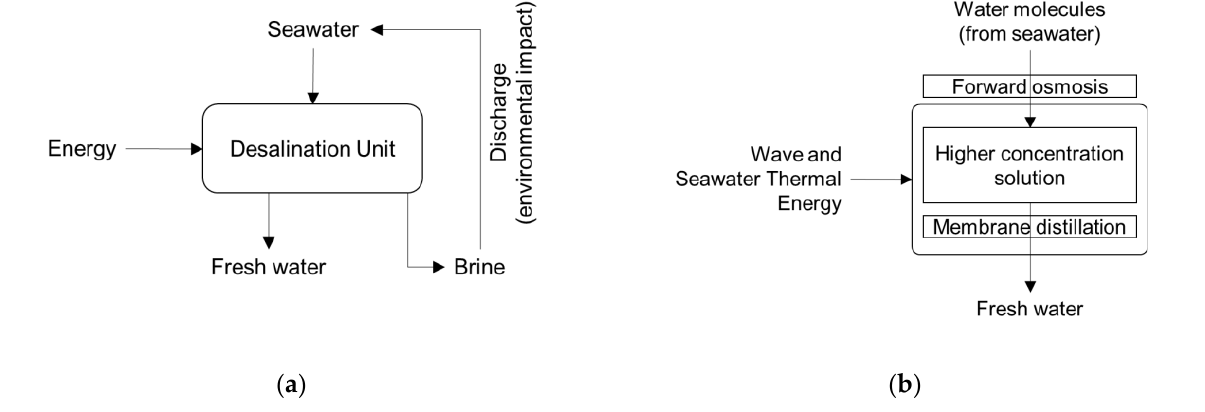
Figure 13. Comparison between ( a ) a conventional desalination system and ( b ) WavoWater.